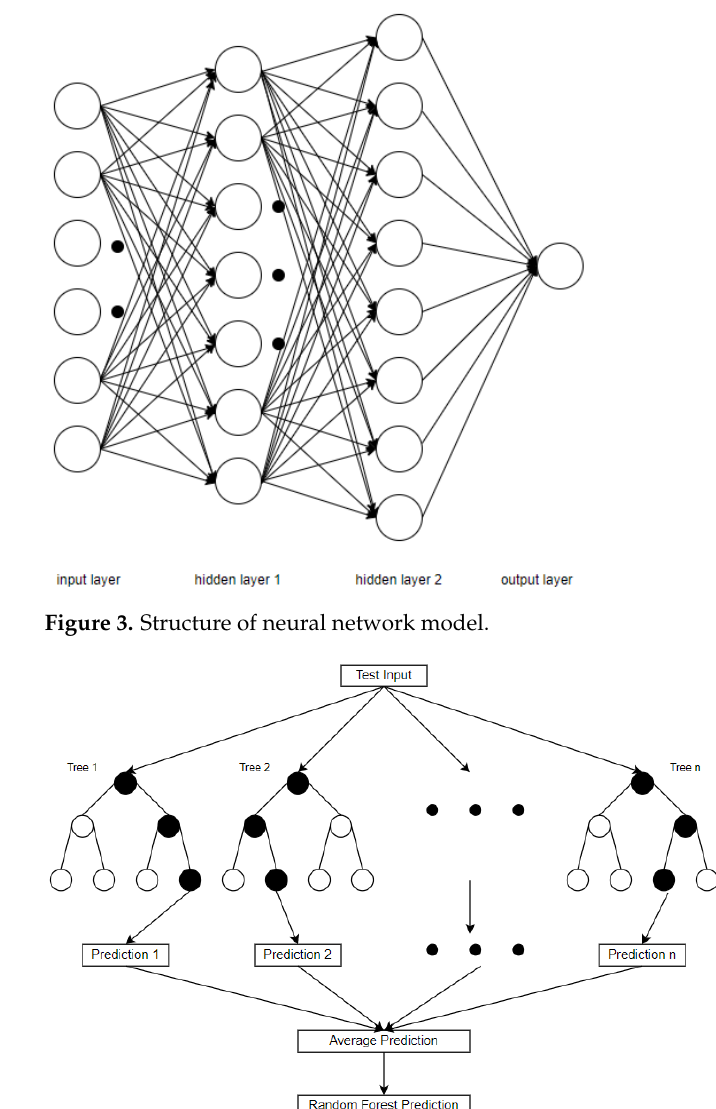
Figure 4. Structure of the random forest model.